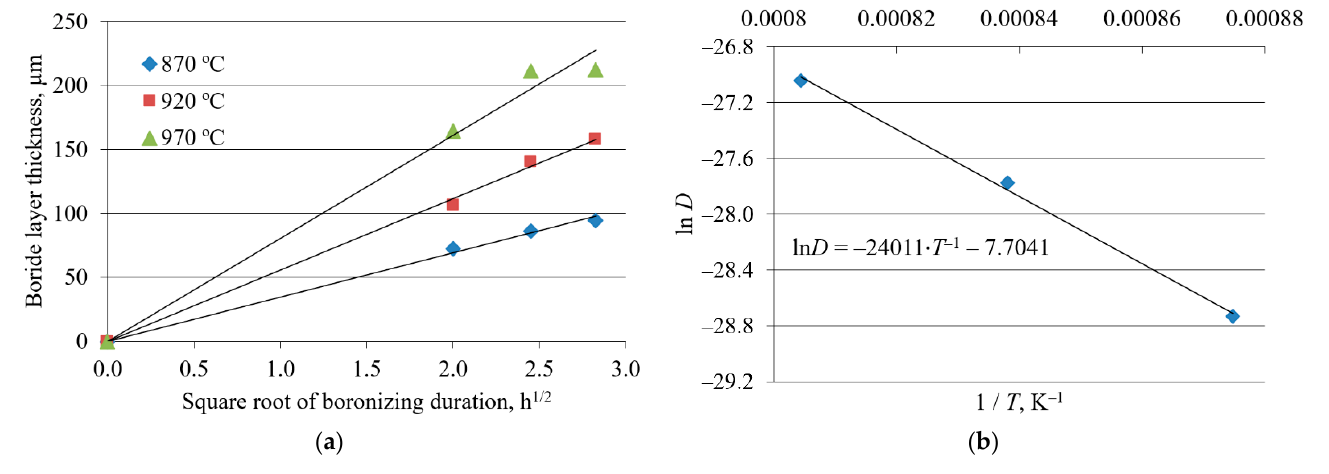
Figure 5. Growth kinetics of boride layers on C15 steel: ( a ) Boride layer thickness as a function of the square root of the boronizing duration; ( b ) natural logarithm of growth rate constant as a func- tion of the reciprocal boronizing temperature [43].